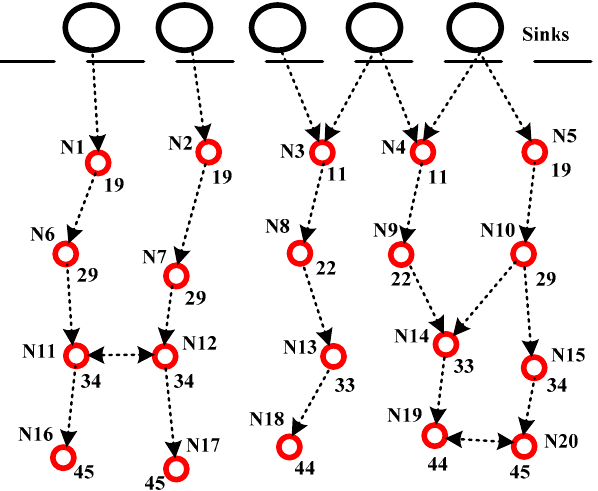
Figure 7. H 2 -DAB addressing Figure 7. H 2 ‐ DAB addressing technique.